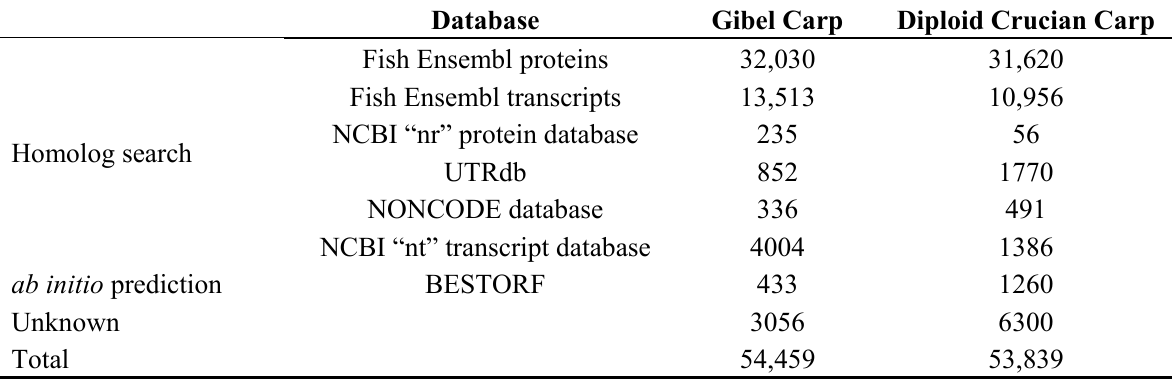
Table 1. Summary of the annotation of transcripts of gibel carp and diploid crucian